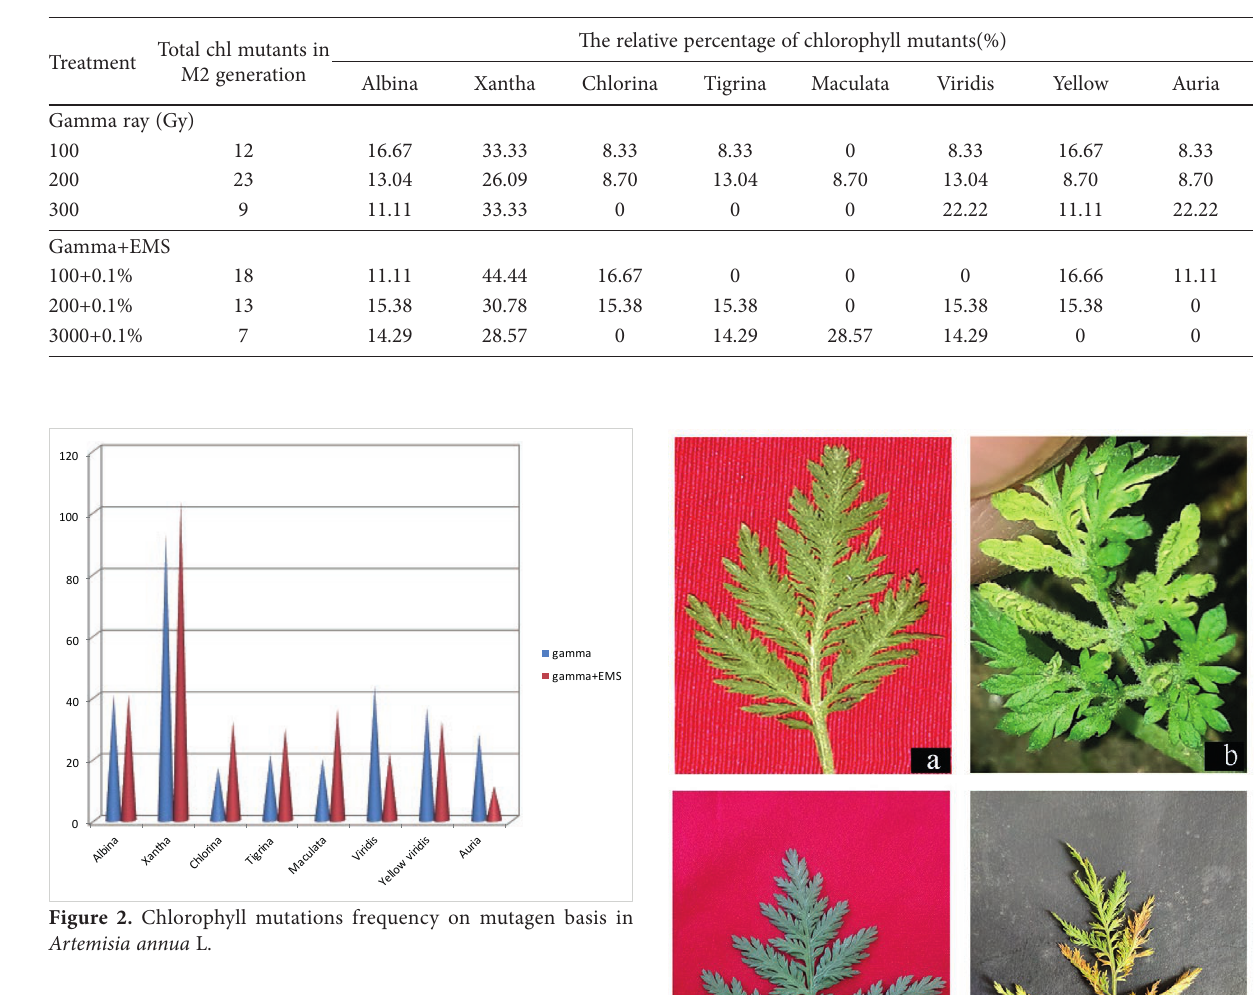
Table 2. Spectrum and Frequency of chlorophyll mutant in diff erent mutagenic treatments.